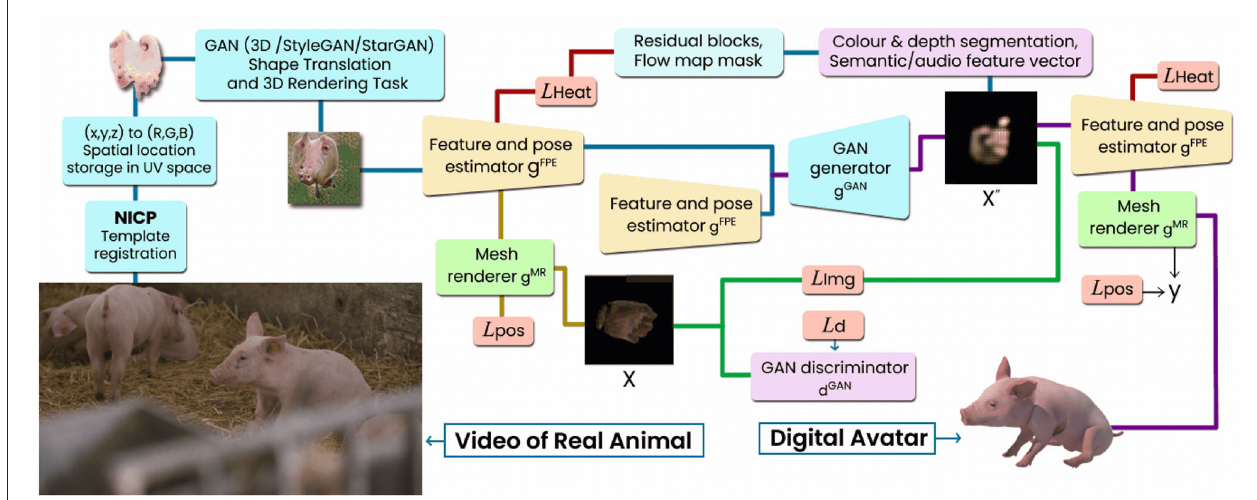
FIGURE 3 | 3D farm animal avatar digitization pipeline from real life video of a pig. Reconstruction of the geometry and texture via GAN model is followed by the generation of the full textured life like animal